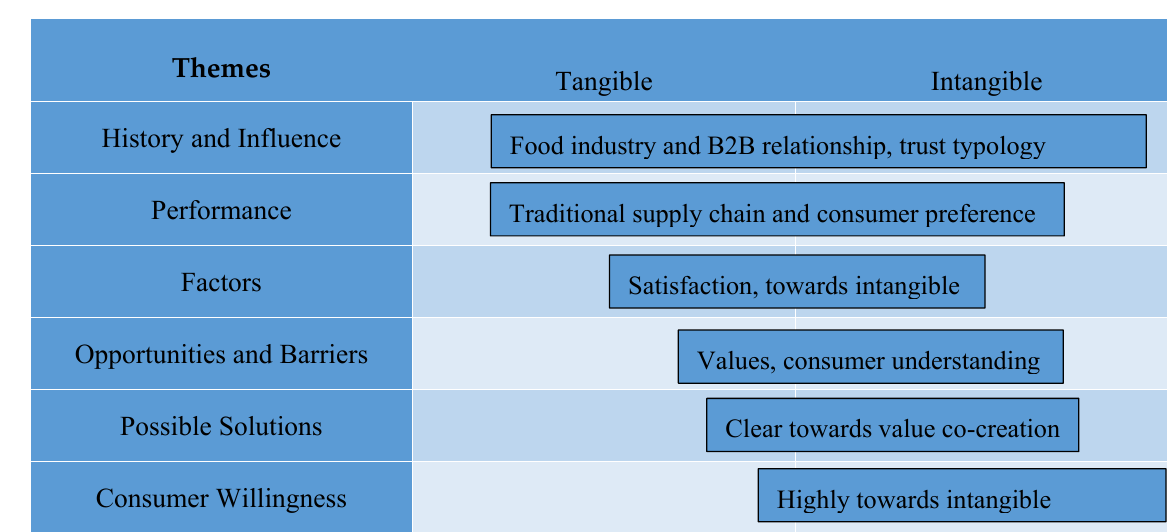
Figure 4. Logic of exchange. As we can see from Figure 4, most of the research has an orientation towards contex- tual and systematic content. An exception is the papers in the History and Influence theme, which try to give a brief overview of AE’s development without diving into multi- dimensional contents, thus being more unidirectional (see Yang et al. (2020) [69] as an example). The theme of Performance starts to consider cultural backgrounds and customs when evaluating AE performance; this theme therefore shows an attempt towards dyadic exchange (through agribusiness companies to consumers, vice versa), but still does not take the exchange context into contextual consideration (for example, advocating commu- nities or third parties join in the exchange process). The theme of Opportunities and Bar- riers analyzes how social networks and information exchange could bring new opportu-